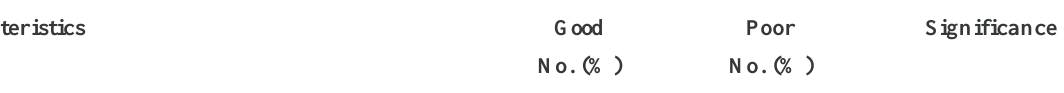
Patients’ knowledge, perceptions and beliefs regarding